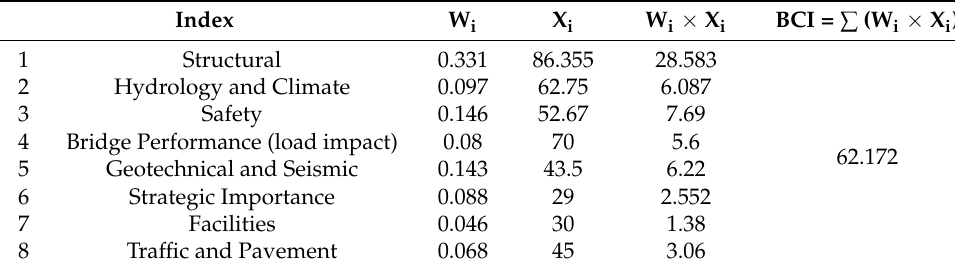
Figure 19. Condition of pavement distresses in bridge NO. 4. Table 21. BCI calculation of the bridge on 6th km of Semnan-Jandaq road.